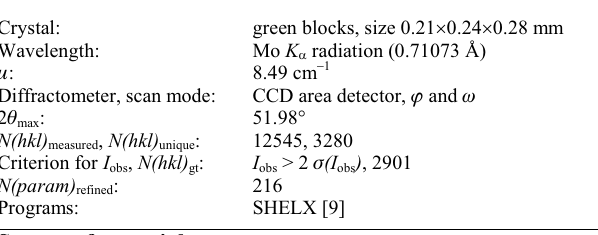
Table 1. Data collection and handling.